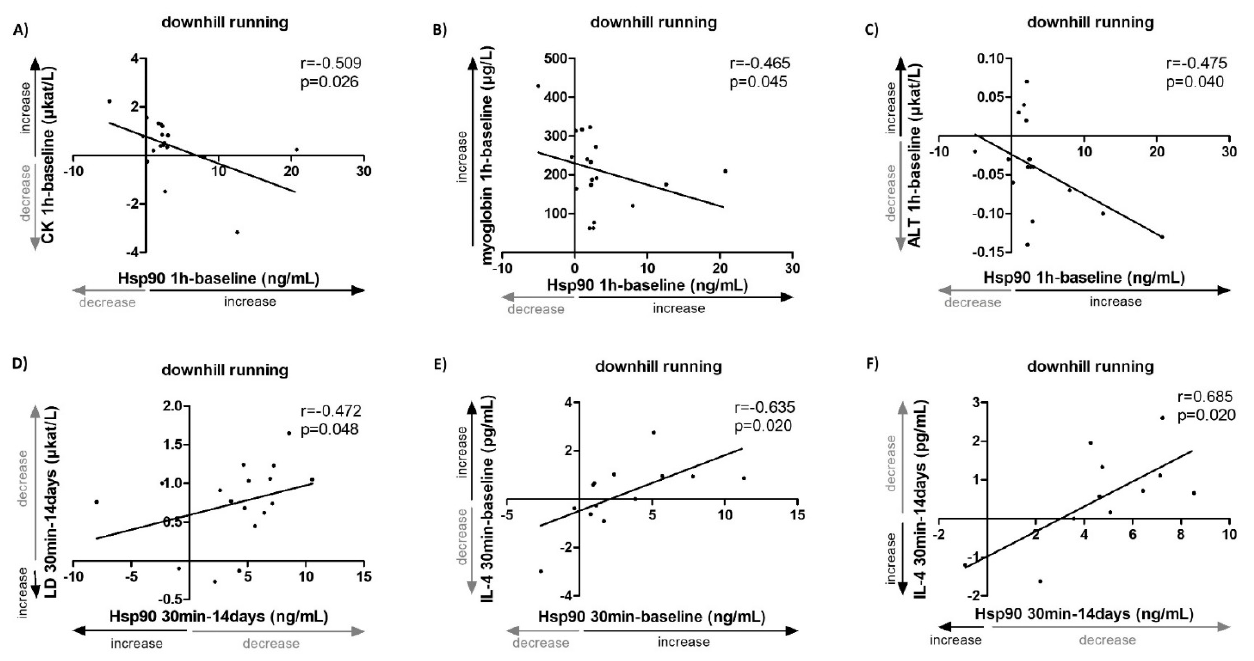
Figure 4. Associations of changes in systemic levels of Hsp90, traditional markers of muscle damage and inflammation in healthy volunteers ( n = 18) upon strenuous exercise. The change in plasma Hsp90 from baseline to 1 h was inversely correlated with change from baseline to 1 h in serum levels of CK ( A ), myoglobin ( B ), and ALT ( C ). ( D ) A decrease in Hsp90 from 30 min to 14 days was associated with a decrease in LD from 30 min to 14 days. ( E ) An increase in Hsp90 from baseline to 30 min was associated with an increase in IL-4 from baseline to 30 min. ( F ) A decrease in Hsp90 from 30 min to 14 days was associated with a decrease in IL-4 from 30 min to 14 days.